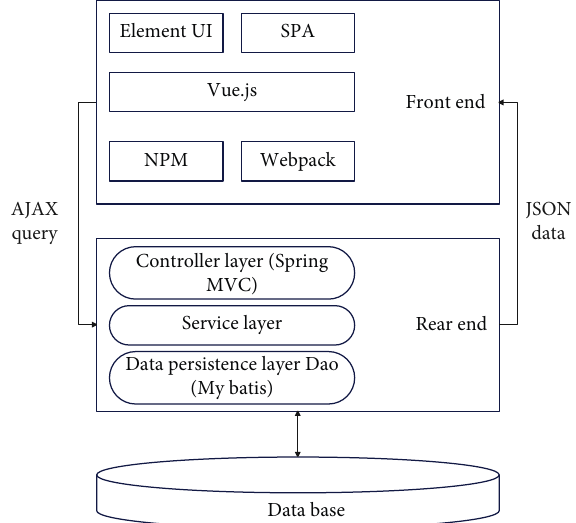
Figure 3: The overall technical architecture design diagram of the system.